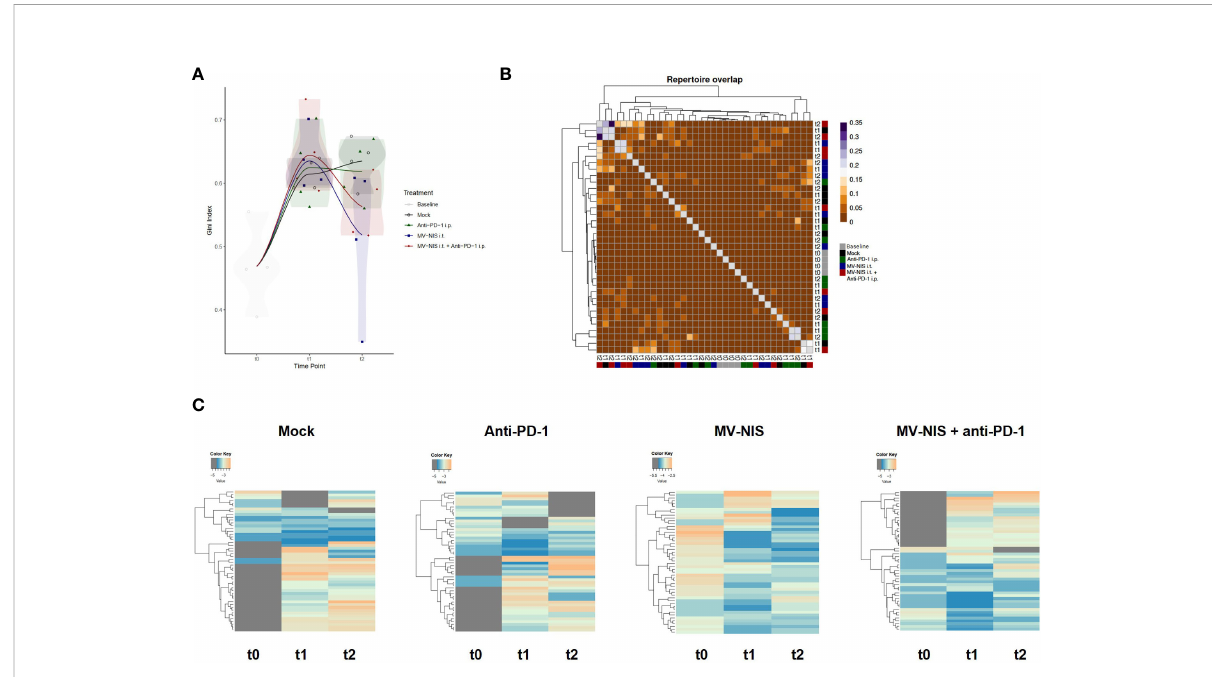
FIGURE 5 T cell receptor repertoire of tumor-in fi ltrating T cells. DNA was extracted from FC1245-CD46 tumor samples collected at indicated timepoints and used for TCR b sequencing. (A) Gini index. (B) Morisita ’ s Horn overlap index. (C) Clonotype tracking was performed with pooled data from four mice in each group at each timepoint based on strict intersection rule using vdjtools. Each row represents one clone, with grey indicating absence of a clone at the respective